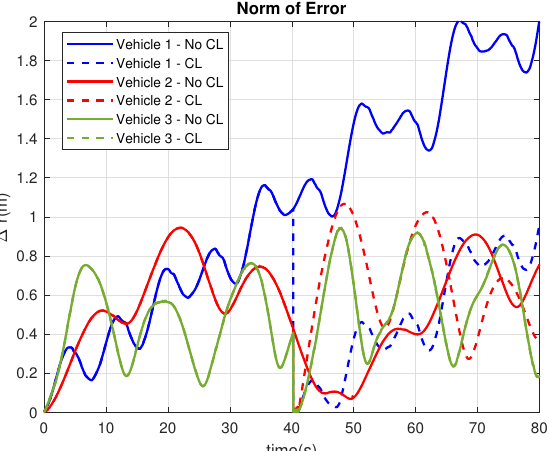
Figure 11. Comparison of error norms when vehicle 3 measures its own pose for 1 s at the 40 s mark. Dashed lines indicate CL with relative and absolute pose measurements starting at 40 s, and solid lines indicate no CL.